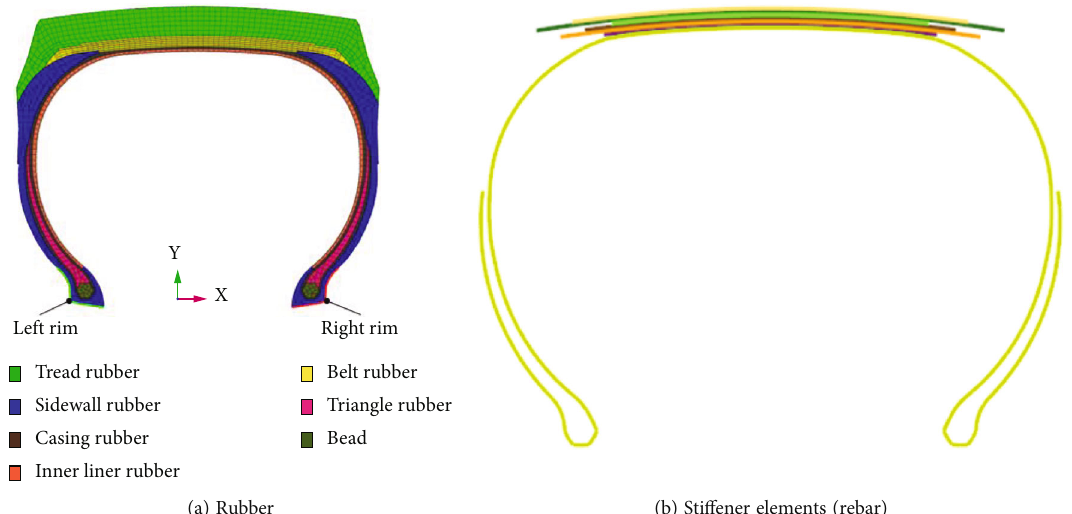
Figure 2: Tire model based on two-dimensional axisymmetric fi nite